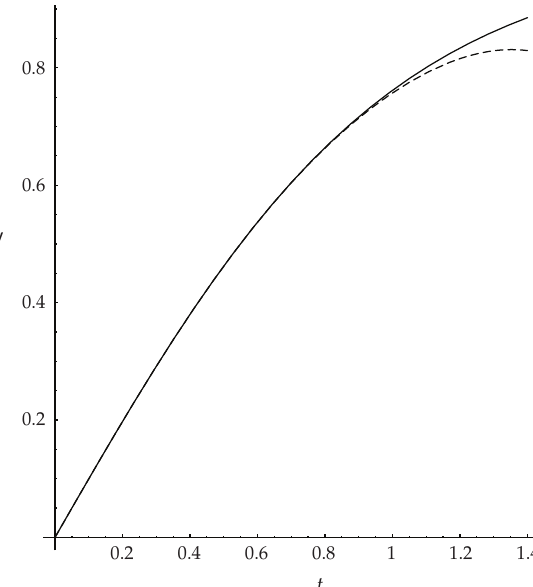
Figure 1: Dashed line: Approximate